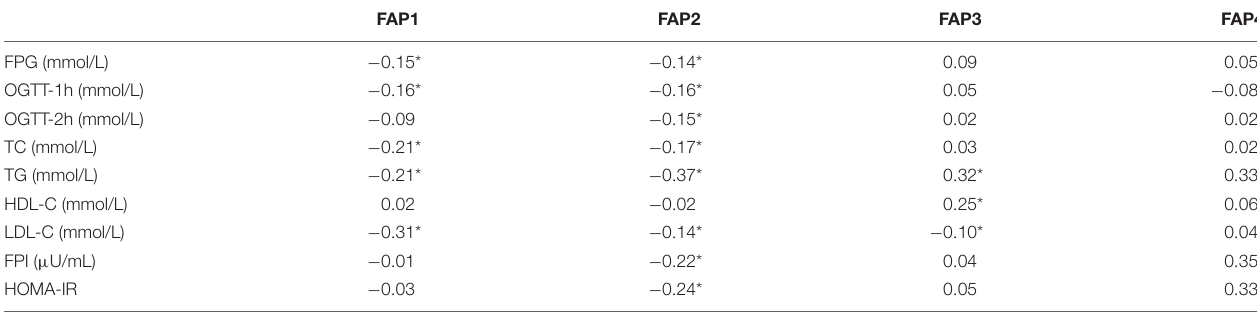
TABLE 5 | Partial correlation coefficients between fatty acid pattern scores and variables of interest a .